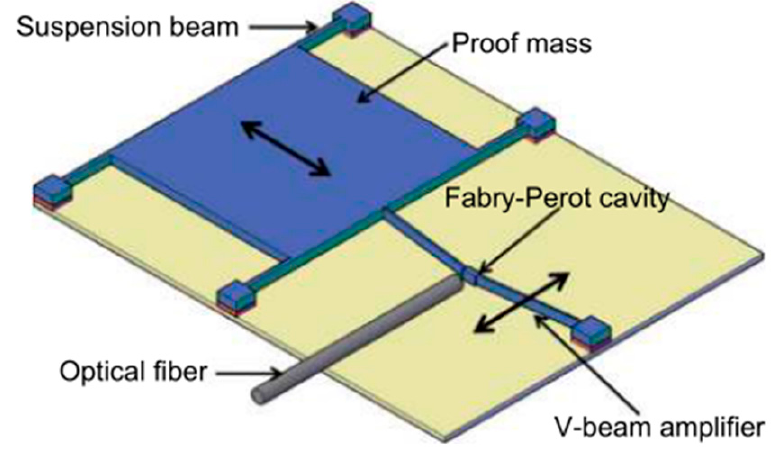
Figure 16. Schematic of a V-beam FPI-based accelerometer. Reprinted with permission from Ref. [59]. Copyright 2014 Elsevier.